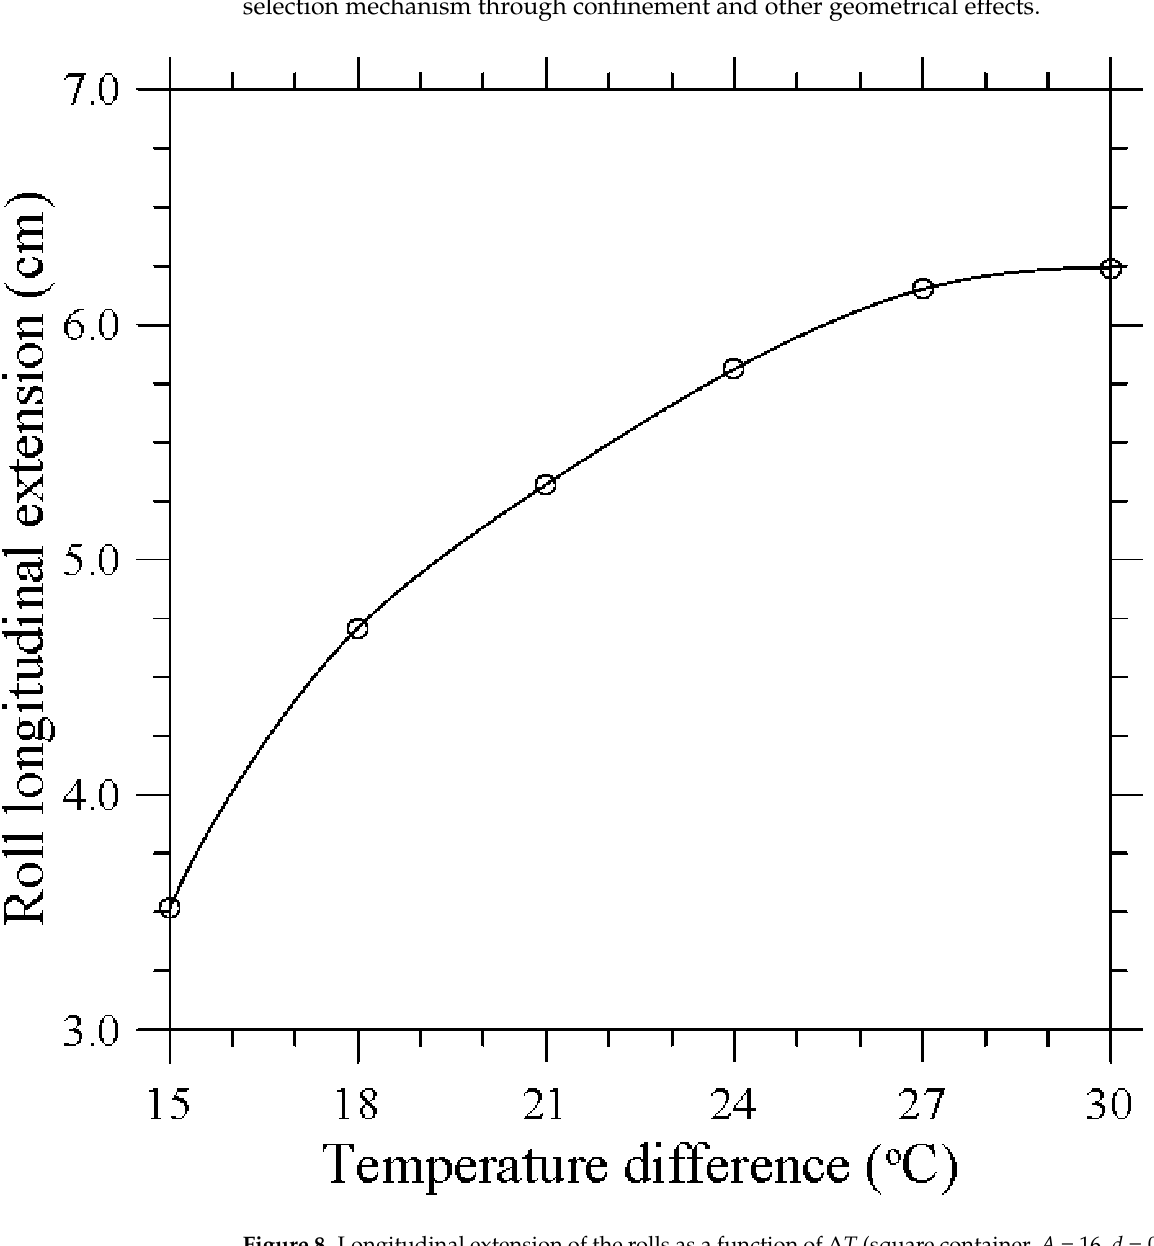
Figure 8. Longitudinal extension of the rolls as a function of ∆ T (square container, A = 16, d = 0.50 cm, Bo dyn ∼ = 0.86, ϑ ∼ = 3.5 ◦).